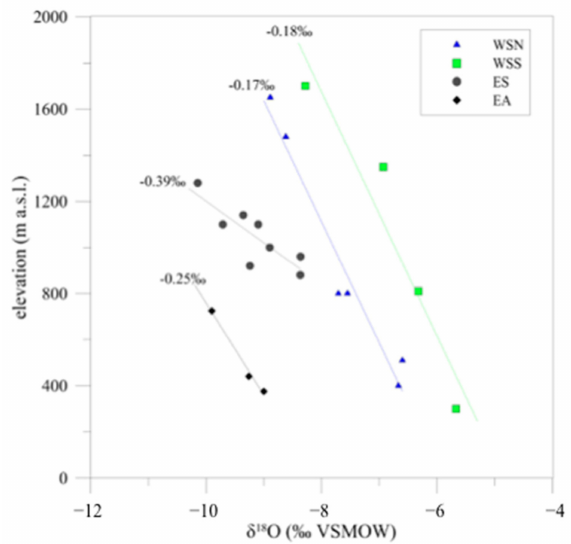
Figure 7. Altitudinal isotopic gradient of the selected